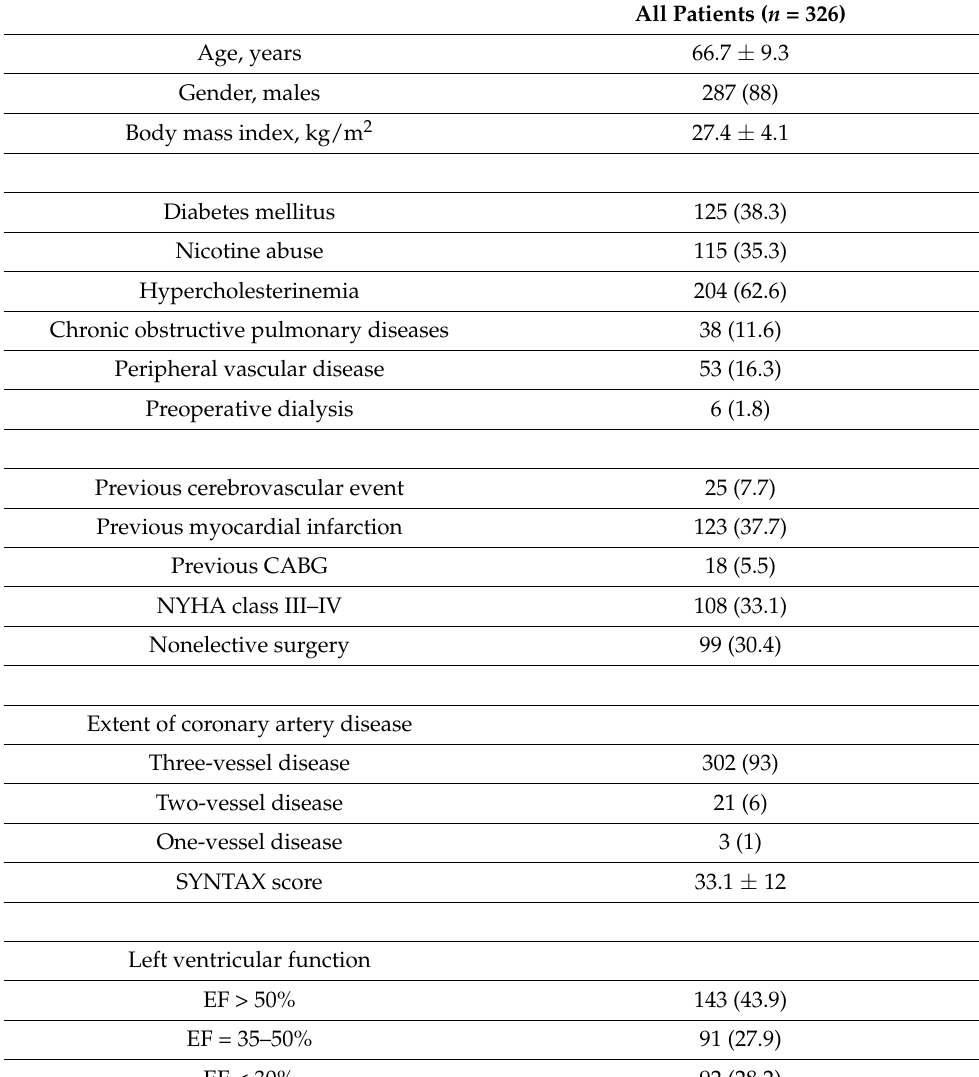
Table 1. Baseline